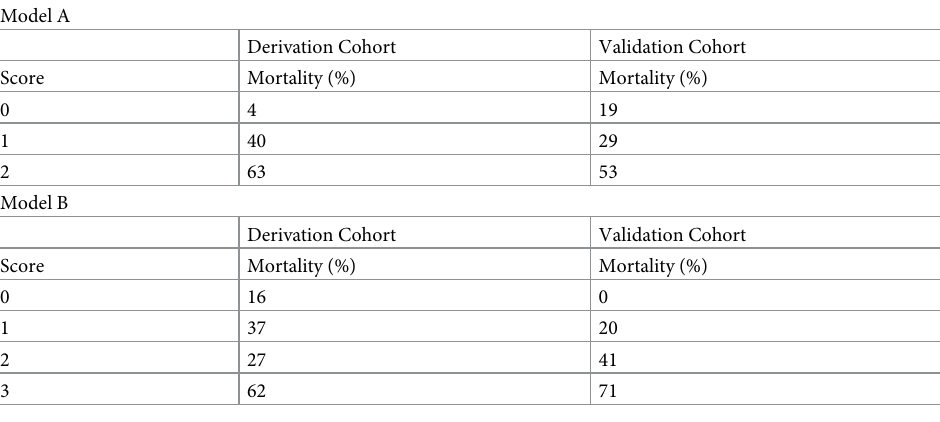
Differences between means (p.) of category scores.